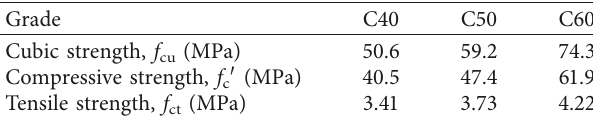
Table 3: Materials properties of